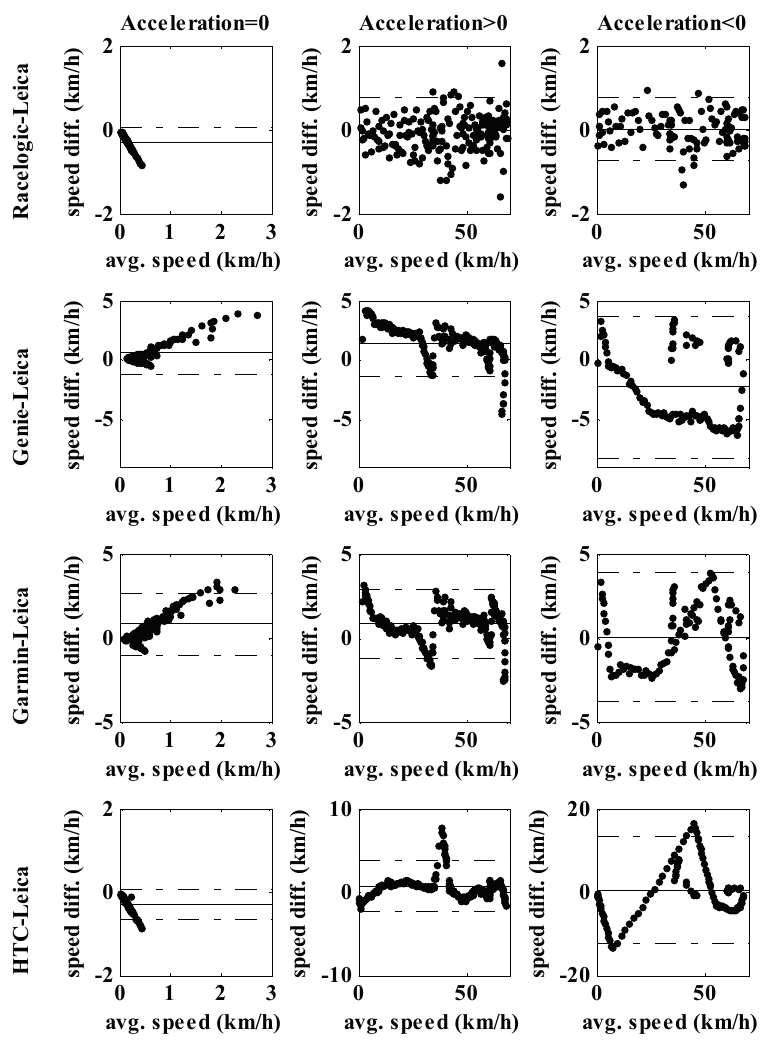
Figure 7. Bland Altman test of agreement between the Leica and other GNSS devices. On x axis is average speed of both compared devices; on y axis is difference in speed between both devices. The first row shows data for steady speed, the second for acceleration and the third deceleration. Full horizontal line represent the mean differences and the dash-dot line 1.96 SD (standard deviation) interval in each diagram. Note that the vertical scale change sometimes in order to improve the visibility of the